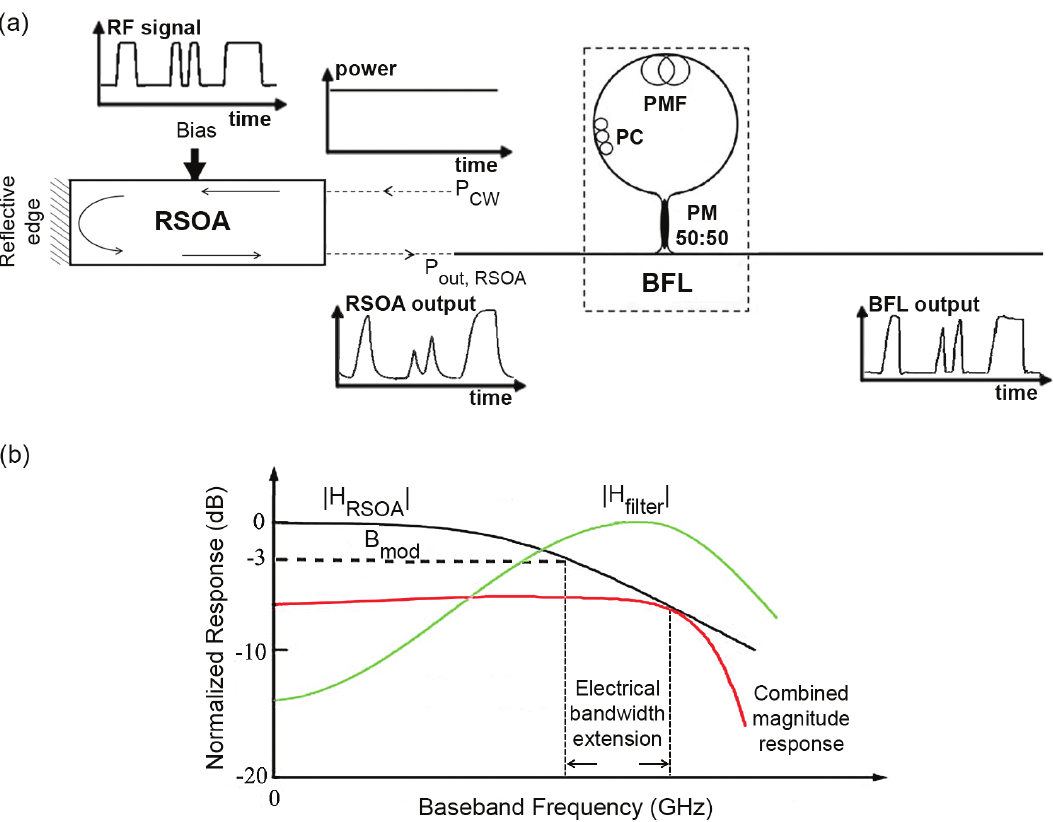
Figure 1. ( a ) Block diagram of directly modulated RSOA followed by a serially connected BFL and ( b ) schematic illustration of RSOA response, | H RSOA | , (black line), transfer function of equalizing filter, | H | , (green line), and combined magnitude response (red line). filter